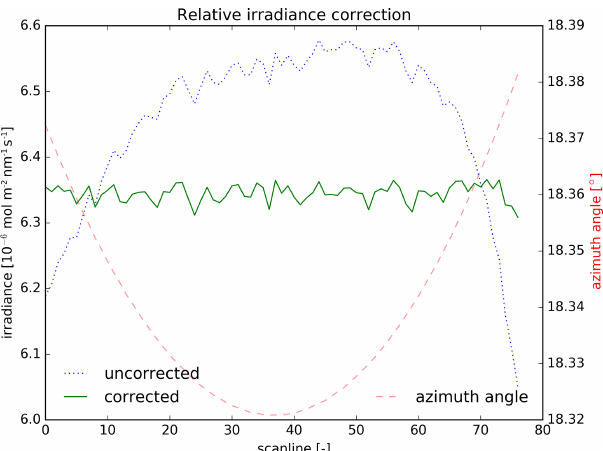
Figure 6. Irradiance data for the VIS detector before (dotted blue line) and after (green line) the relative irradiance correction by the L01b processor. Data are shown for a single orbit, so there is a more or less constant solar azimuth angle around 18.32 ◦ (dashed red line). Within the measurement the solar elevation angle changes from − 4 to + 4 ◦ in the time dimension.